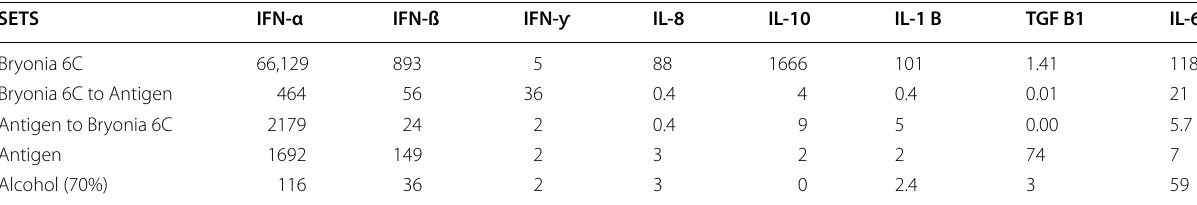
Table 1 Increase in cytokines (fold increase in comparison with normal control) in different experimental sets after 48 h